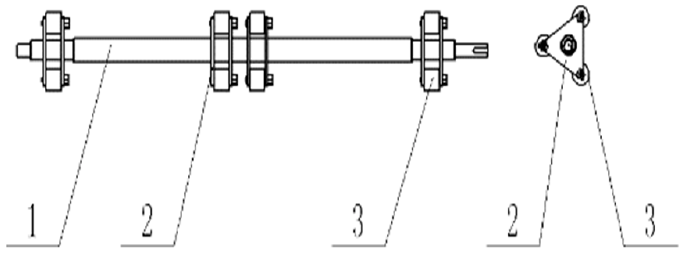
Figure 7. Schematic of the jitter roller. 1 drive shaft; 2 shaking frame, and 3 rollers. Based on the speed of the chain during operation, the speed of the jitter rollers is calculated according to Equation (5) as follows: